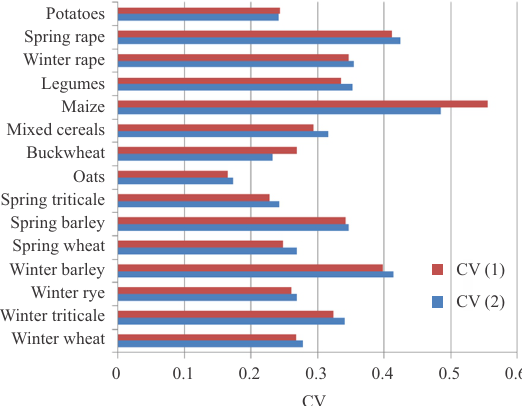
Fig. 4. Coefficients of variation (CVs) for expected yield loss across different